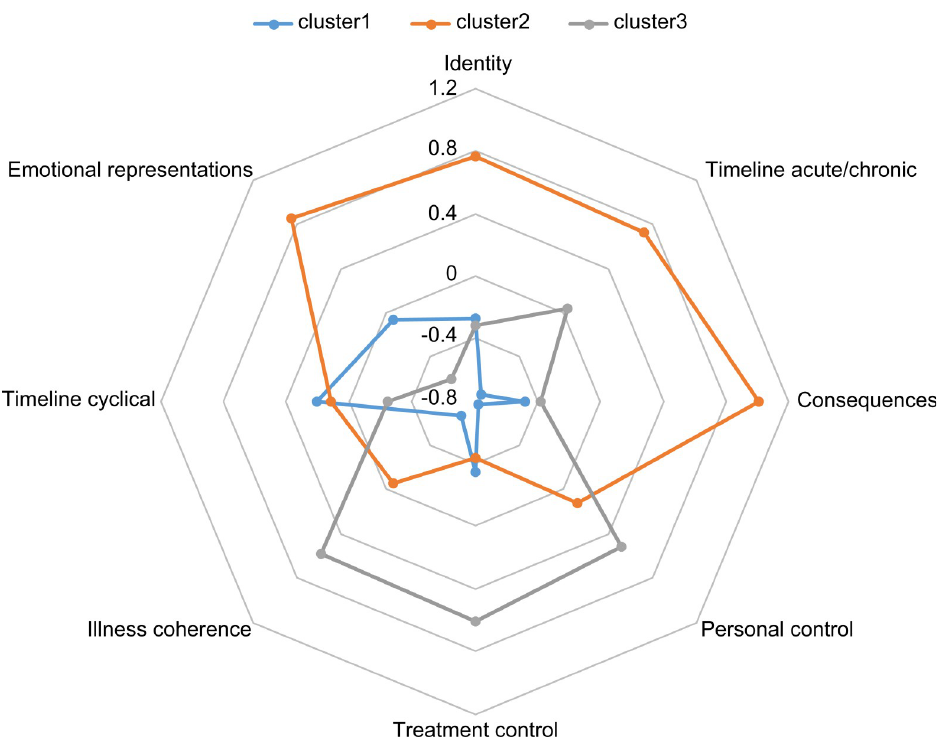
Fig 1. Comparison of each domain of the IPQ-R mean scores (z-scores) by clusters. Cluster 1 represented the difficulty of making sense of the changed condition caused by the disease and easily falling into misunderstanding (blue). Cluster 2 represents patients with disease conditions that have impacted their daily life and emotional responses (orange). Cluster 3 represents the controllability and understanding of the disease (gray). IPQ-R, Illness Perception Questionnaire-Revised.